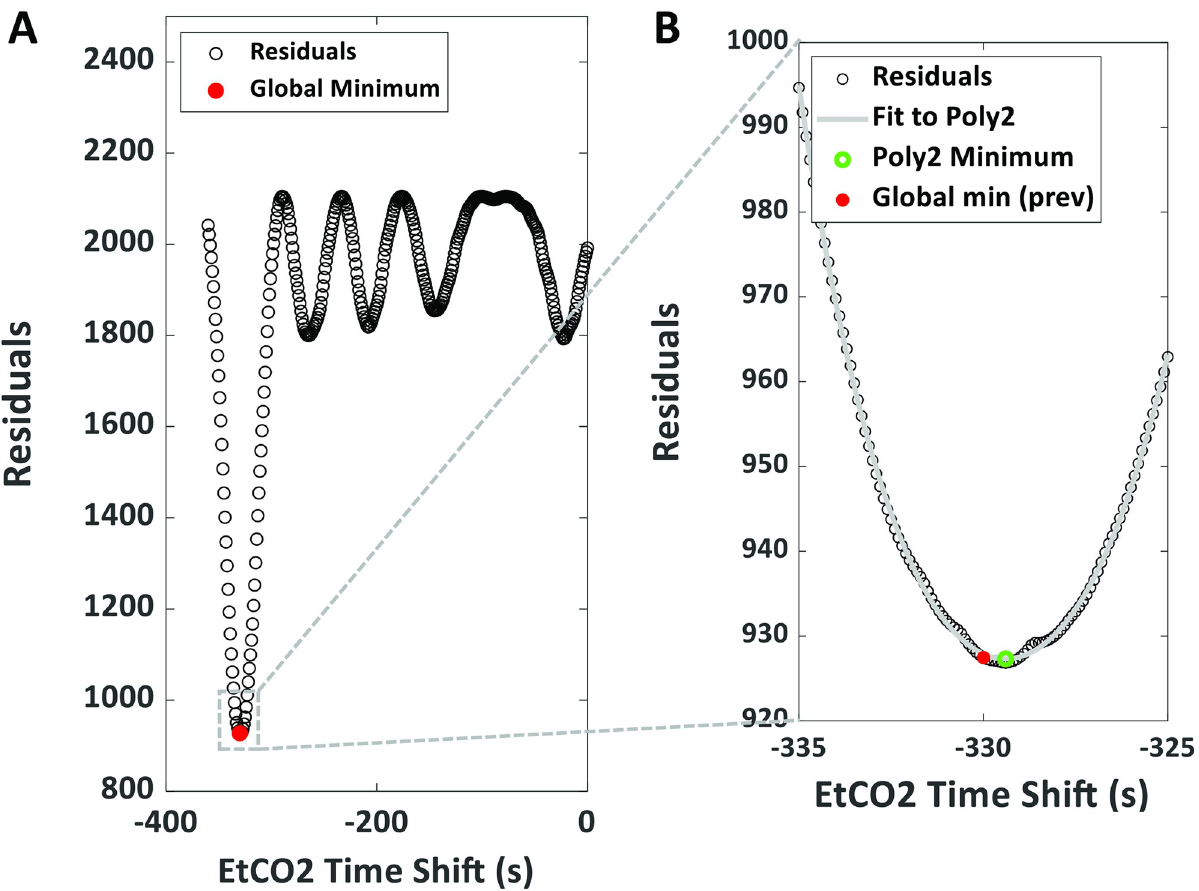
Fig 4. Example of the two-step processing for the temporal alignment between BOLD and EtCO2 time courses. (A) Plot of the residual error from the GLM in Eq [1] as a function of time shift in a representative subject. Red dot indicates the time shift that reveals the minimal residual error. (B) Results of the second-step alignment. The plot displays the residual error at each time shift within the 10s range (box in (A)) around the minumal point determined in the first step (red dot). The final optimal time shift (green circle) was determined from the second-degree polynomial fitting of the